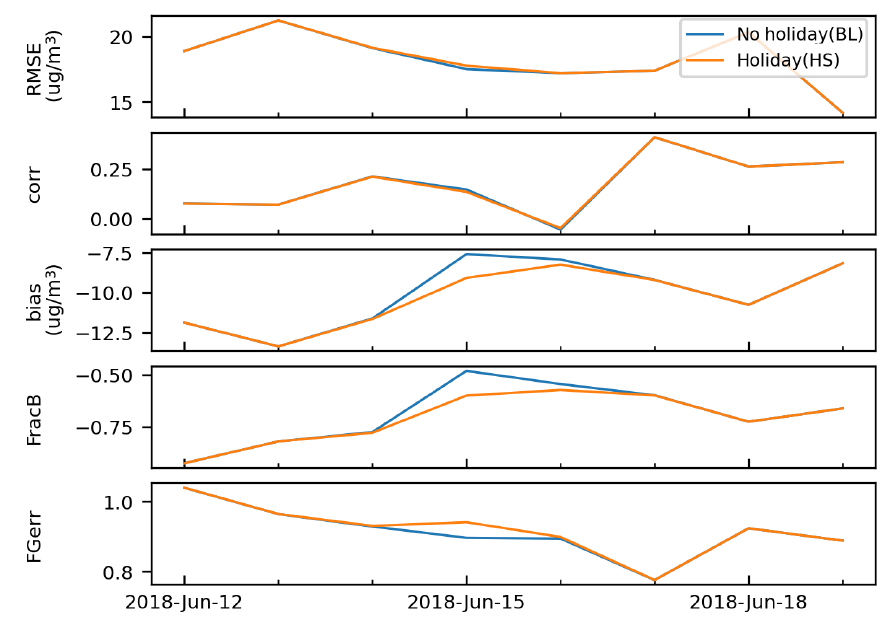
Figure 6. SILAM daily-mean spatial scores for Ramadan (NO 2 , only stations in